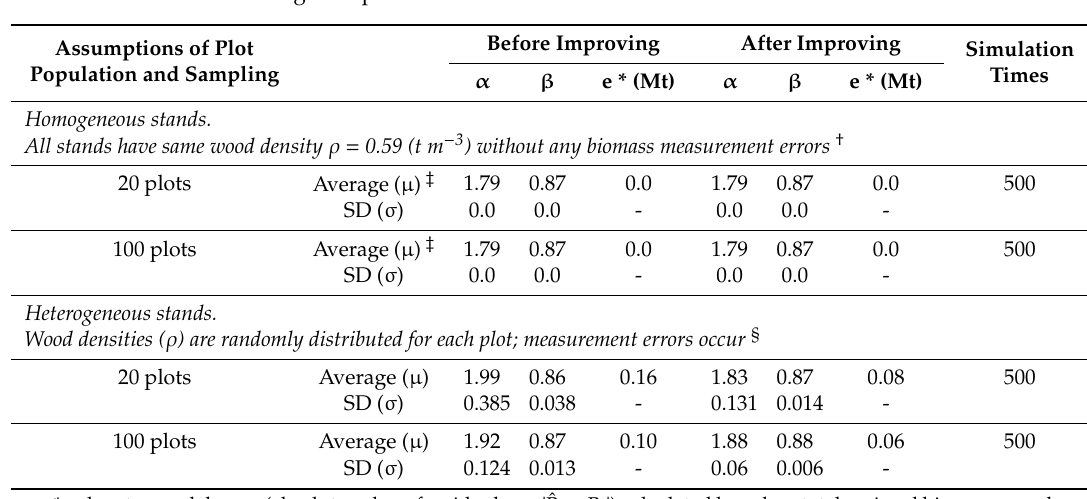
Table 2. The comparison between the results before and after improving parameters ( α and β ) of volume-SABB equations. These equations are regressed based on the simulation data (refer to Supporting Information Table S1). Parameter ( α and β ) and residual distributions resulted from 500 simulations of setting field